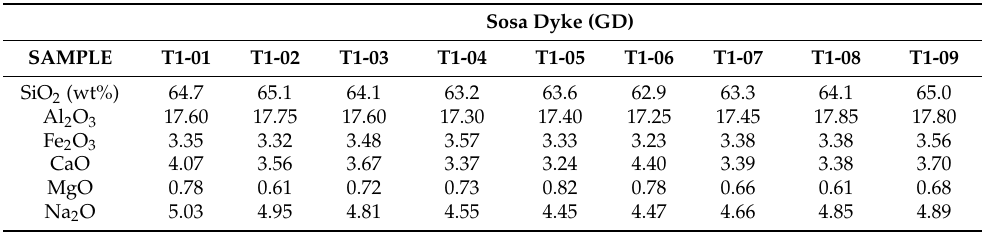
Table A1. Whole-rock major (wt%) and trace element (ppm) ICP analyses of samples from the Sosa dyke traverse T1 for sample locations see Figure